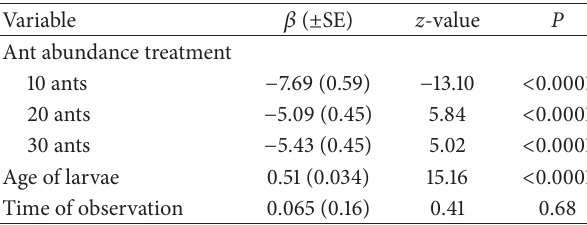
Table 1: Results of generalized linear mixed-effects model testing the effects of ant abundance treatment (10, 20 or 30 ants), larval age (d) and time of observation (morning or afternoon) on the probability that ants would be tending Miami blue butterfly larvae. 𝛽 is the coefficient describing the shape of the logistic curve (Figure 2). The table below presents the tests of contrasts among levels of ant abundance (the 𝑃 -value of the 10 ant treatment is from a test against the null of 𝛽 = 0 and the 𝑃 -values associated with the 20 and 30 ant treatments indicate the difference between those treatments and the 10 ant treatment). The interaction term between ant abundance treatment and age of larvae was not significant so was removed to more accurately assess the main effects.